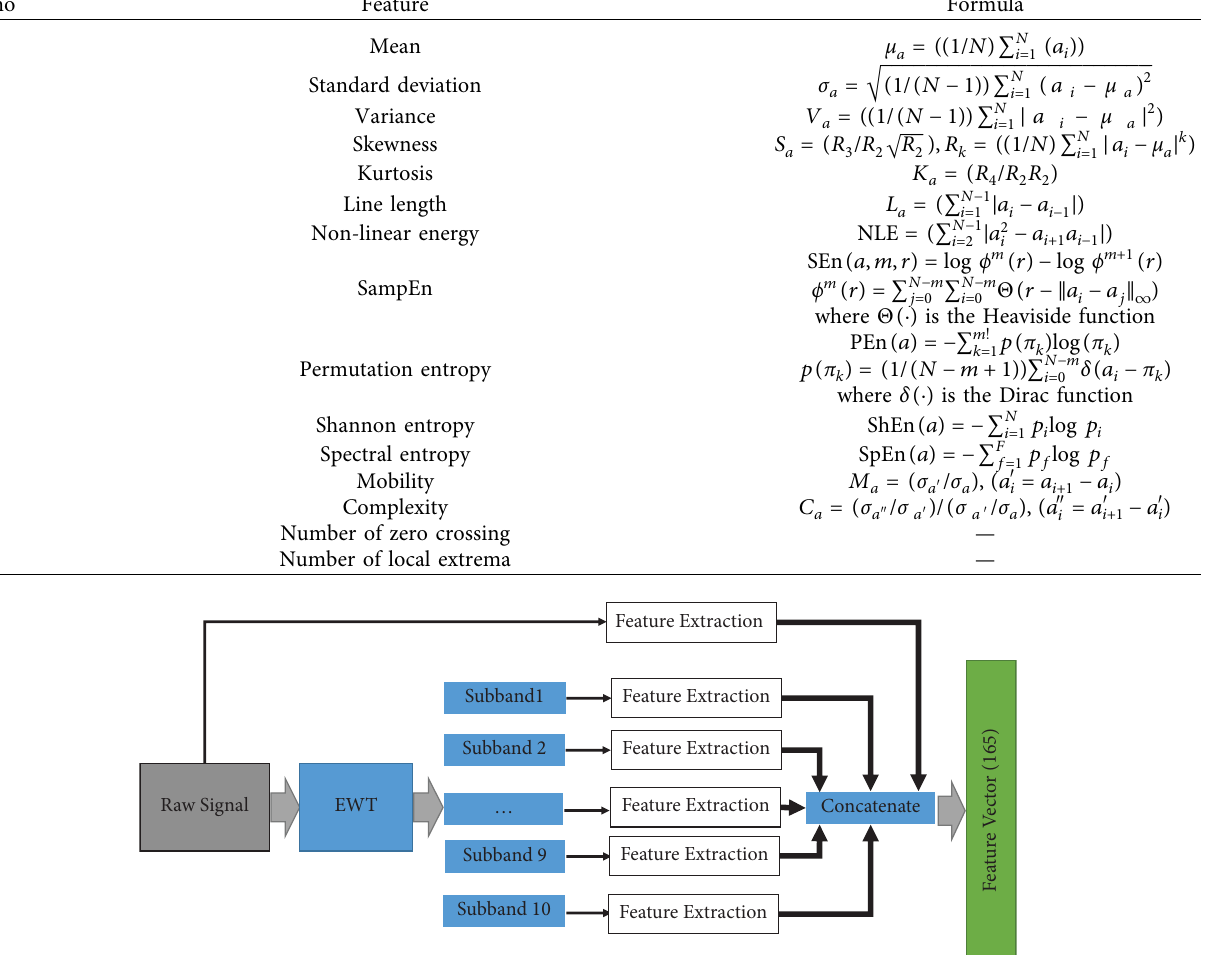
Figure 5: Illustration of feature extraction